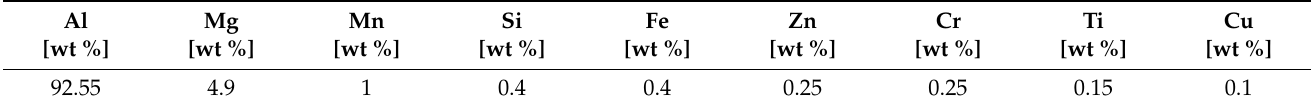
Table 1. The chemical composition of AA 5083-H111.